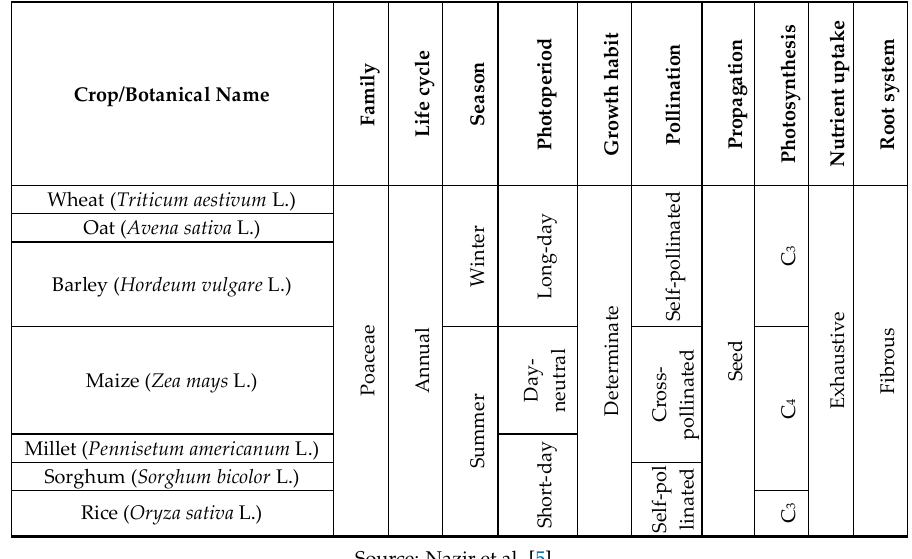
Table 1. Classification of commonly grown C 3 and C 4 cereal crops in Asia.